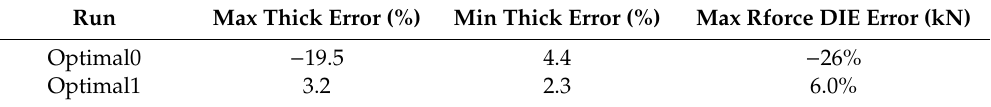
Table 11. Percentage error calculation of numerical results vs regression model